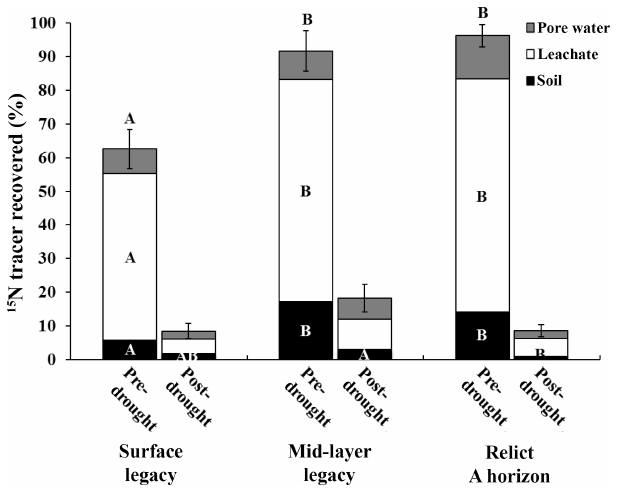
− ) (%) recovered in the Figure 3. Amount of tracer 15 N (as 15 NO 3 soil (black bars), leachate (white bars), and pore water (gray bars) pools pre-drought and post-drought. Vertical bars denote 1 standard error of the mean for the total of the three pools combined ( n = 5). For a given sampling time (i.e., pre-drought or post-drought) different letters above the standard error bars represent statistically significant ( P< 0 . 05) differences in the total recovery of 15 N (i.e., soil + leachate + pore water) across soil horizons. For a given 15 N pool (i.e., soil or leachate or pore water) and sampling time (i.e., pre-drought or post-drought) different letters represent statistically significant ( P< 0 . 05) differences across soil